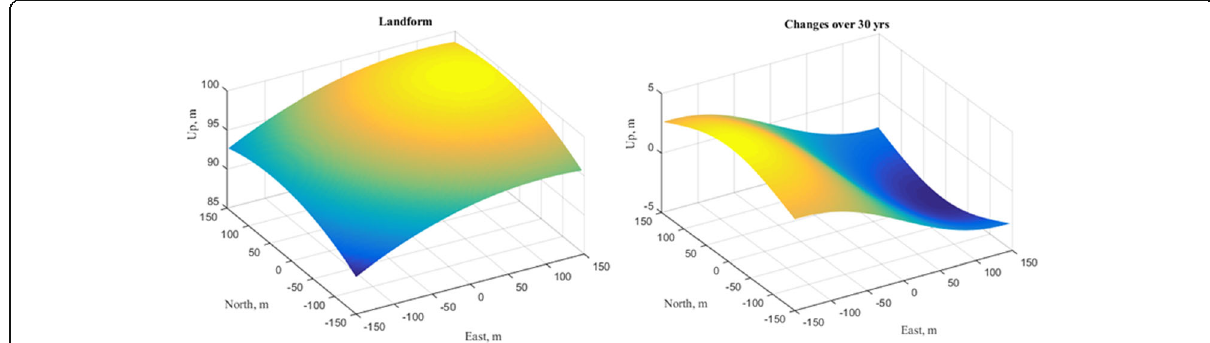
Fig. 1 Simulated landform ( left ) and accumulated changes over 30 years ( right ). The magnitude of change is approximately ± 5